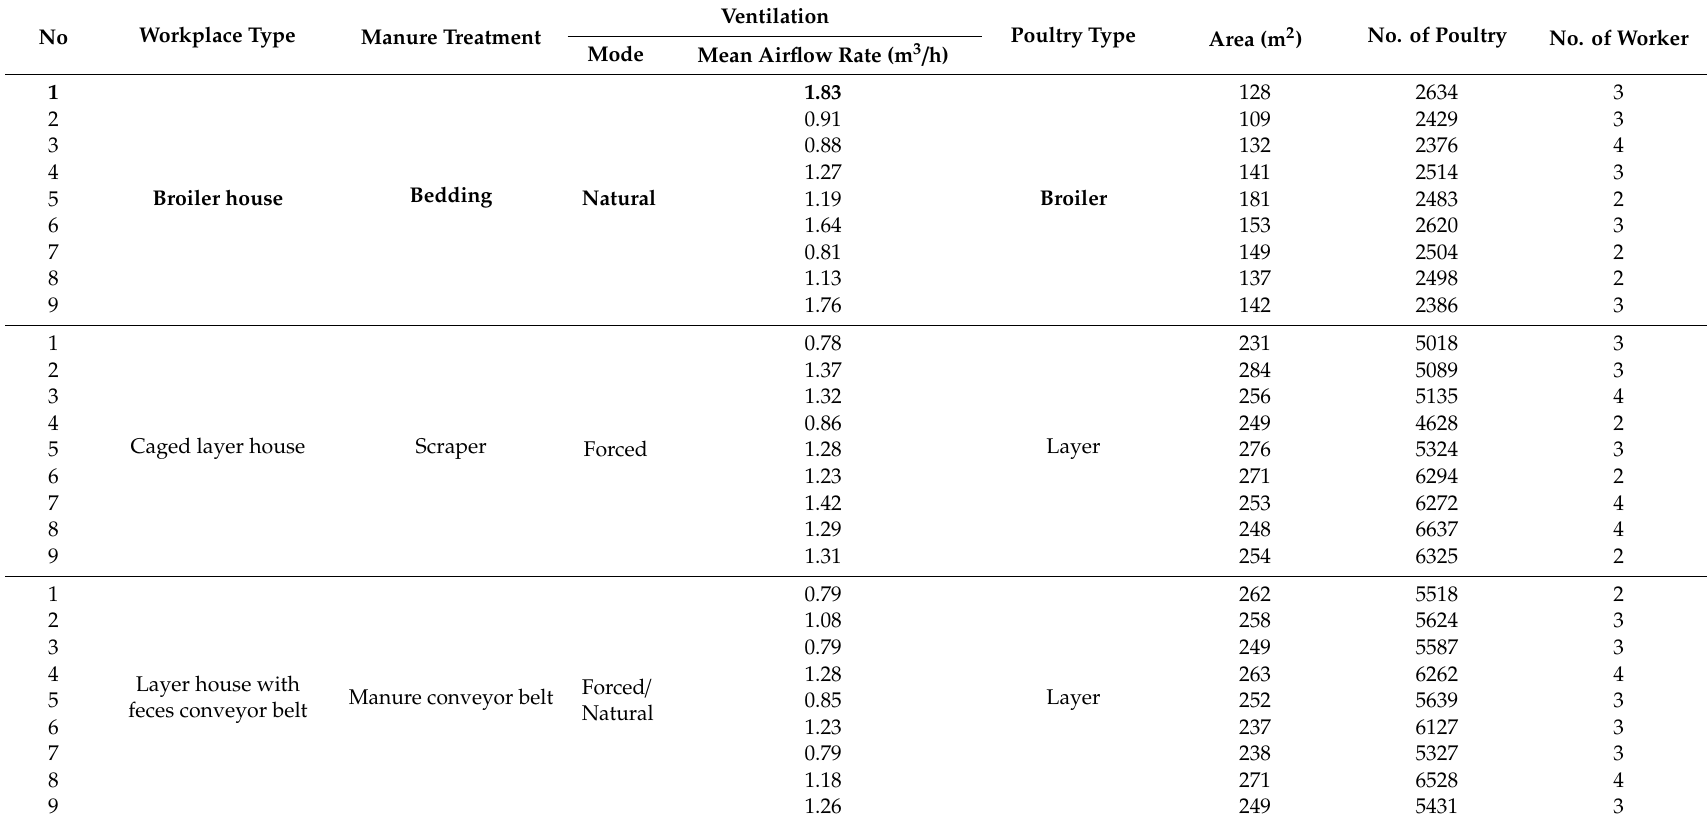
Table 1. Overview of poultry houses investigated in this